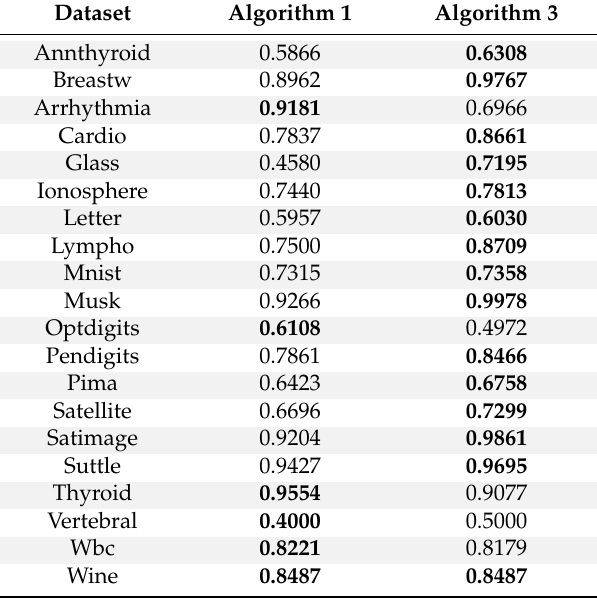
Table 2. AUC score comparison between Algorithm 1 and Algorithm 3. The highest values of AUC scores are marked in